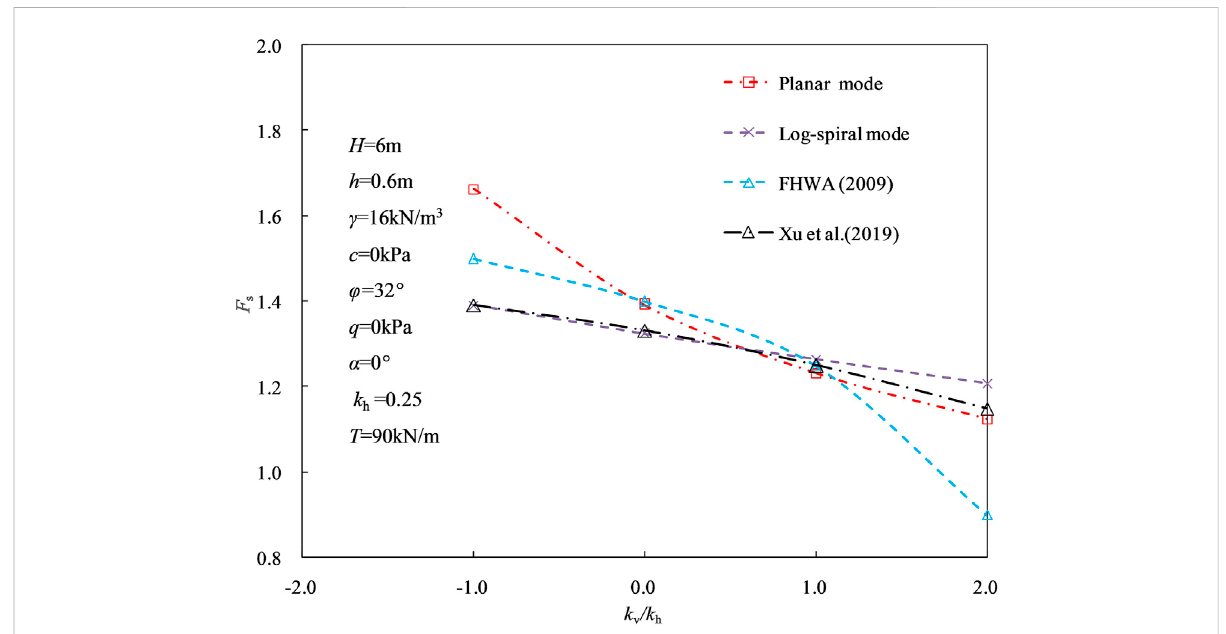
FIGURE 7 Comparison of factor of safety of another example using different methods.